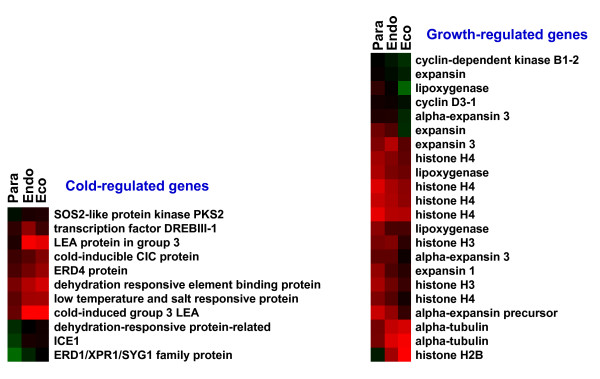
Heat map diagram of relative gene expression levels for probable cold-regulated and growth-regulated genes. Red color indicates relative increase in expression, and green color represents relative decrease in expression.